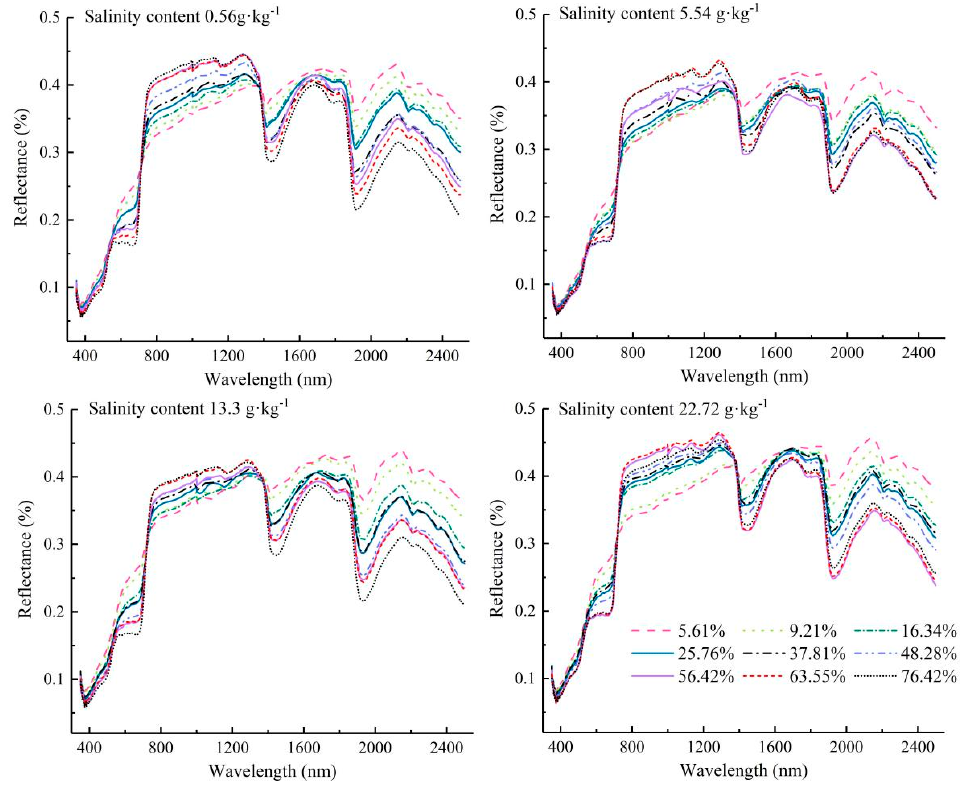
Figure 5. Average reflectance of salty soil with different FVCs.